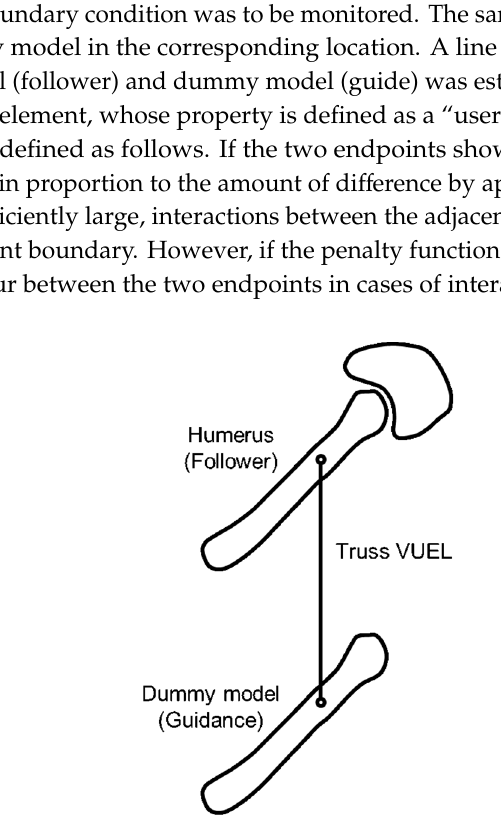
Figure 4. Abaqus user element (VUEL) connecting the dummy and humerus model.